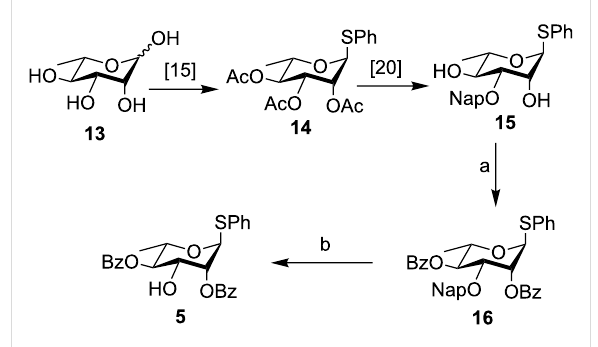
Scheme 2: Preparation of L-rhamnosyl acceptor 5 . Reaction condi- tions: a) Py, BzCl, rt, 12 h, 99%; b) DDQ, DCM/H 2 O (19:1), rt, 2 h,